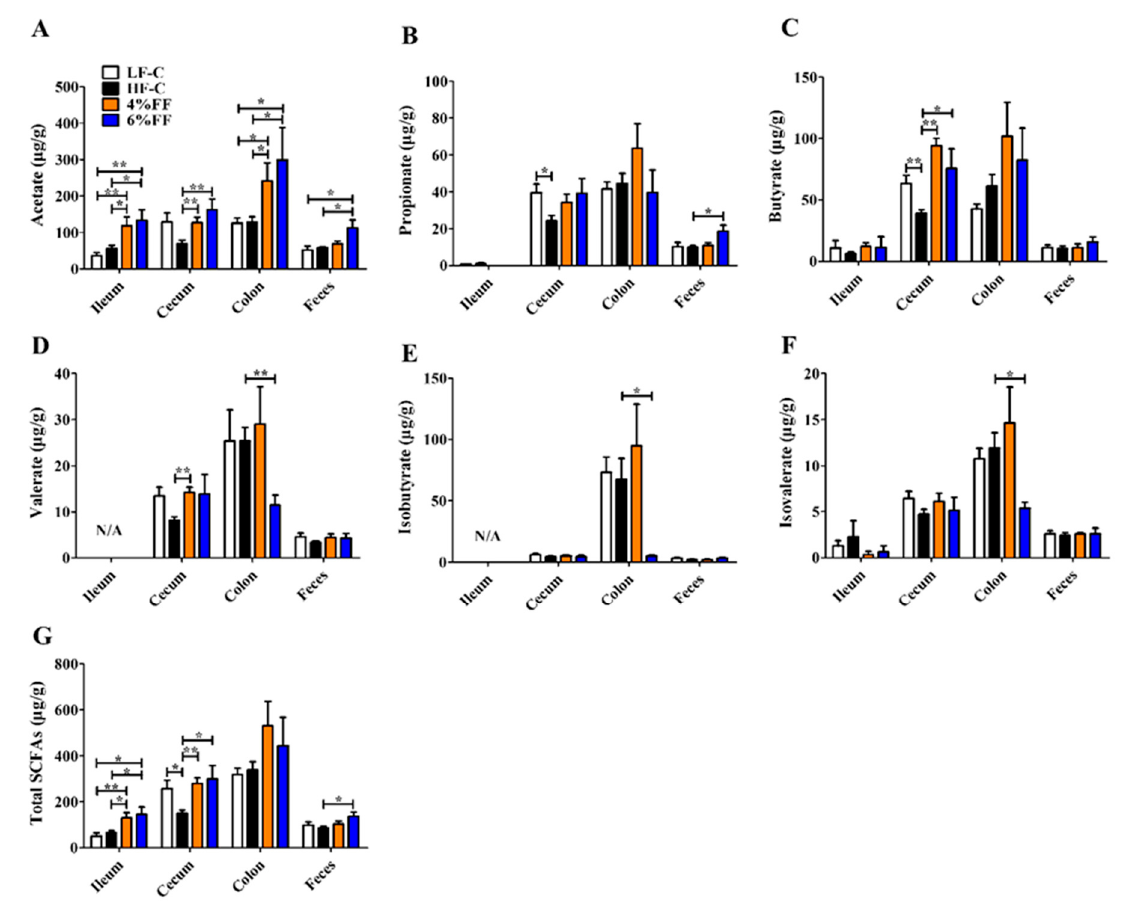
Figure 10. Changes in the production of short-chain fatty acids (SCFAs) in each intestinal segment: acetate ( A ), propionate ( B ), butyrate ( C ), valerate ( D ), isobutyrate ( E ), isovalerate ( F ), and total SCFAs ( G ). Data are represented as mean ± S.E.M., n = 5–7. Significance is considered at p < 0.05. * means in the same bar without a common letter differ at p < 0.05; ** means in the same bar without a common letter differ at p < 0.01.